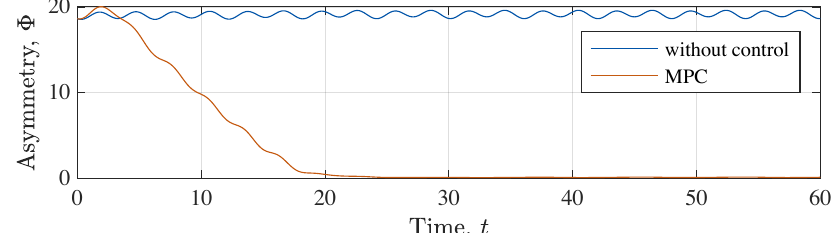
Figure 3. Contours of the vorticity of the flows ( a ) without control and ( b ) with MPC).